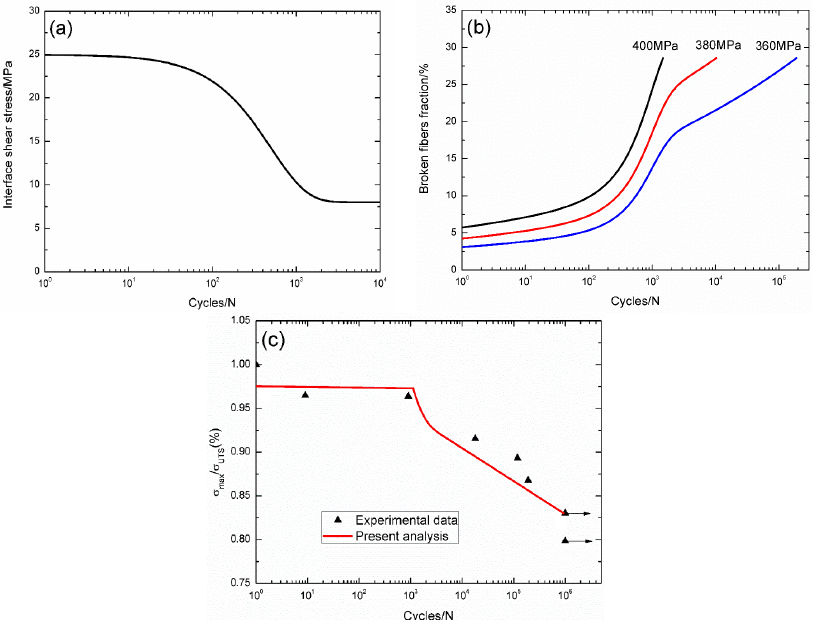
Figure 6. ( a ) The interface shear stress versus applied cycles; ( b ) the broken fibers fraction versus applied cycles; and ( c ) the fatigue life S–N curves of experimental data and theoretical analysis for 2D C/SiC composite at room temperature.